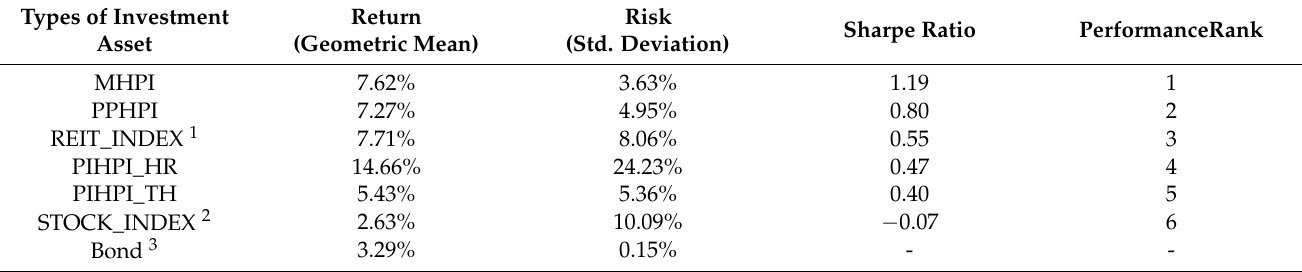
Table 6. Quality of Investment Asset for Study Period